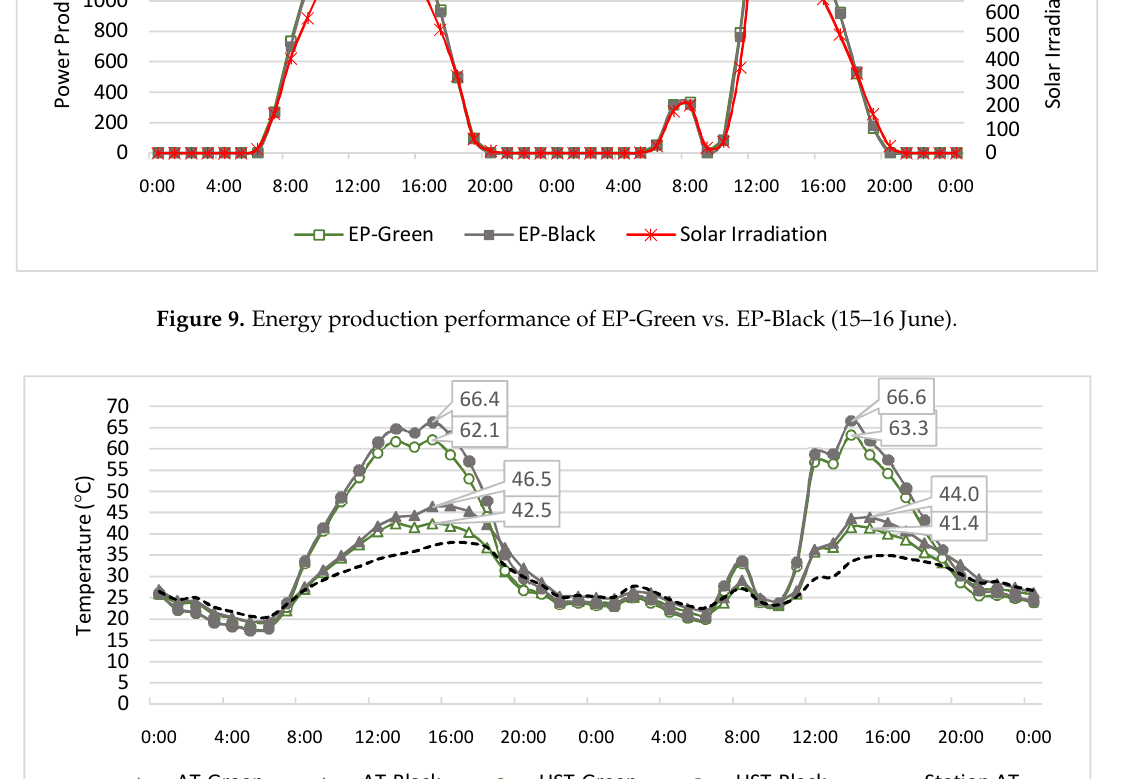
Figure 10. Thermal performance of AT-Green and UST-Green vs. AT-Black and UST-Black. The energy production profiles for 19–20 July are shown in Figure 11. On the first day, the maximum energy production by EP-Green at peak hours was 1715 Wh, and EP-Black was 1698 Wh. On the second day, the maximum energy production by EP-Green at peak hours was 1667 Wh, while EP-Black was 1627 Wh. The energy production profiles show maximum temperature differences of about 47 Wh and 40 Wh at the peak production for the first day and the second day, respectively. This translates to differences of 2.8% and 2.5% between EP-Green and EP-Black in the peak energy production values. The solar irradiation and energy production profiles show similar patterns and the peak solar irradiation values were 922 W/m 2 on the first day and 908 W/m 2 on the second day.